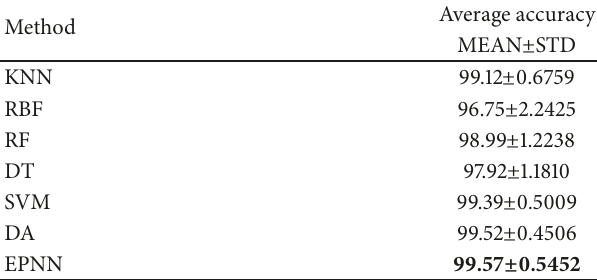
Table 10: Classification performance of EPNN in comparison with other classification methods on Qualitative Bankruptcy